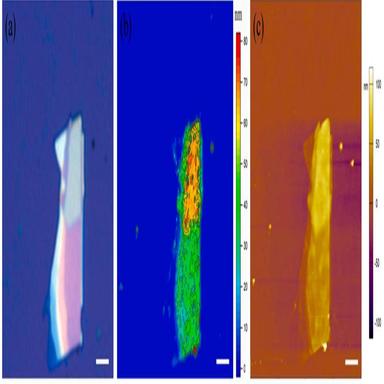
Three-dimensional characterization of optical images (10 μm in scale). (a) MoS2 imaging under optical microscope. (b) Three-dimensional image prediction (the black lines in the figure are the contour lines). (c) AFM characterization of samples.